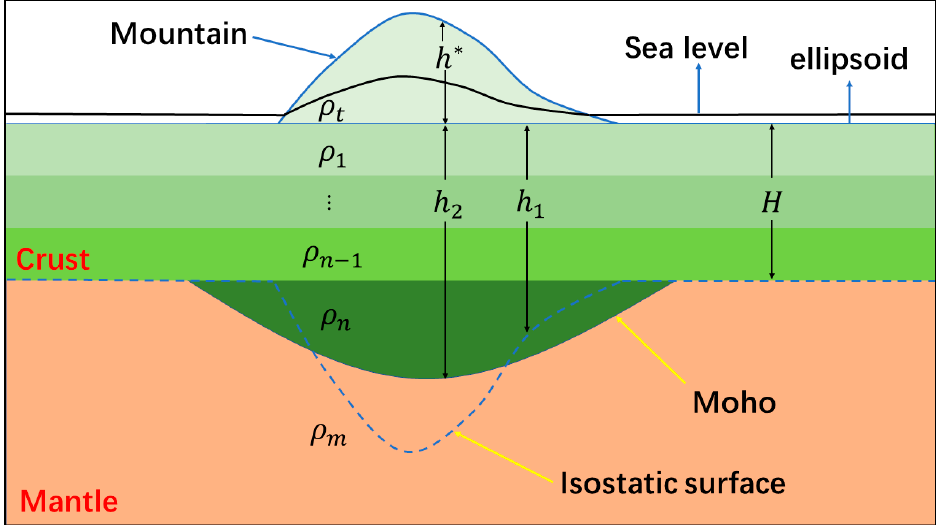
Figure 3. Schematic diagram of the relationship between the Moho and isostatic surface.